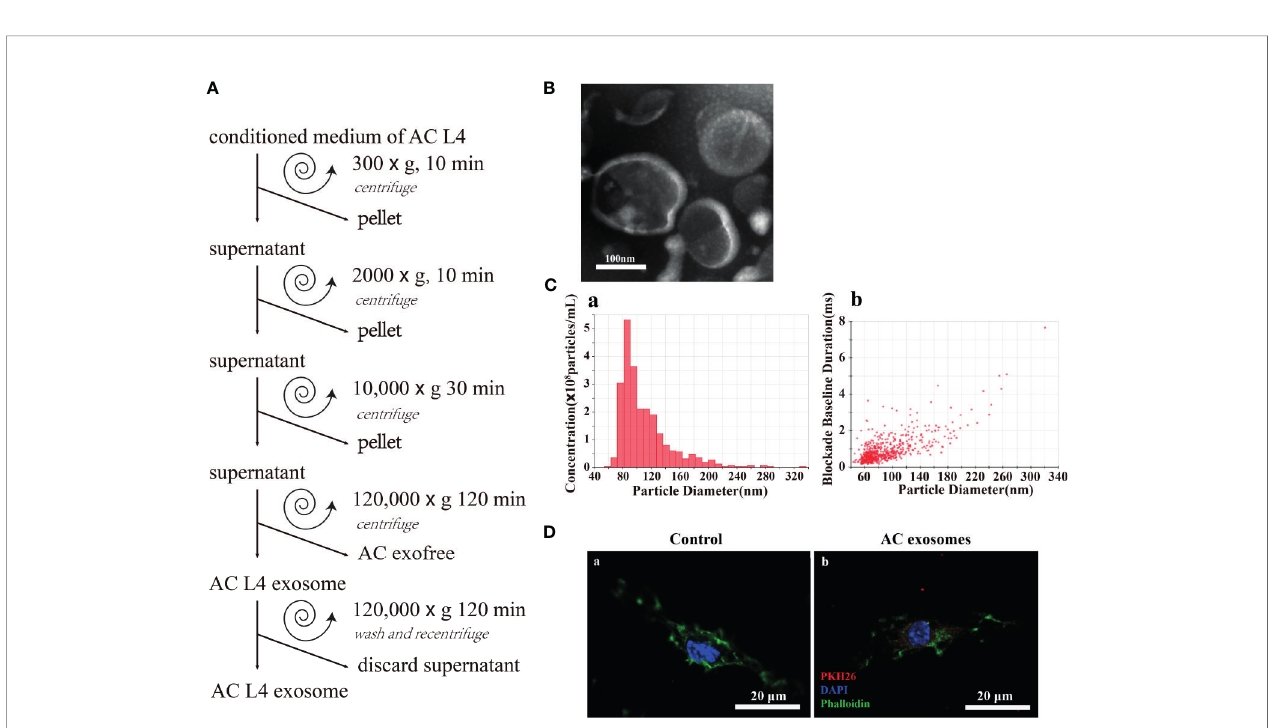
FIGURE 2 | Excretory-secretory products from the fourth stage larva of A. cantonensis could be further classi fi ed into AC L4 exosome and AC L4 exofree. (A) Scheme of AC L4 exosomes and AC L4 exofree isolation by differential ultracentrifugation from conditioned medium of the fourth stage larva of A. cantonensis . (B) Morphological characterization of AC L4 exosomes were identi fi ed using transmission electron microscope. (C) Concentration and size distribution of AC L4 exosomes were measured by IZON qNano particle analyzer. (D) BMDMs were incubated with PBS (a) or 5 m g/ml PKH26-labeled AC L4 exosomes (b) for 1 h, and a confocal analysis was performed to evaluate exosome internalization. Phalloidin was used to label actin (green), and DAPI was used for the staining of nuclei (blue). Scale bar=20 m